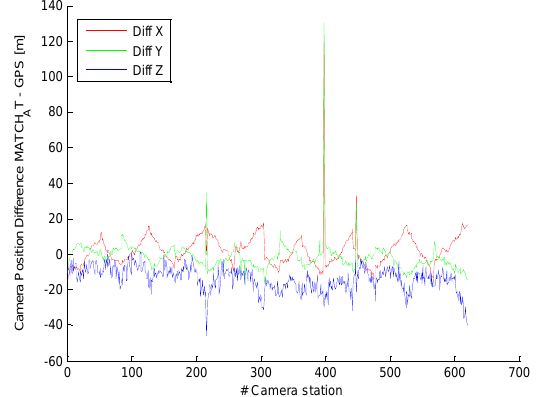
Figure 7: Differences at camera stations between outcome from MATCH-AT and GPS measurement.